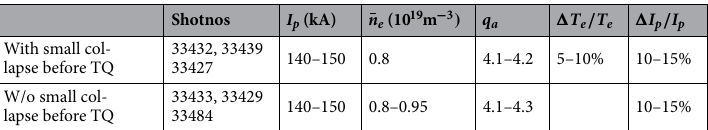
Table 1. List of the shotnumbers and parameters ( I p , ¯ n e and q a ) in disruptive discharges with and without a small collapse before the TQ. The last two columns are the relative reduction of temperature ( � T e / T e ) caused by the small collapse and plasma current ( � I p / I p ) by partial disruption (CQ phase), respectively.